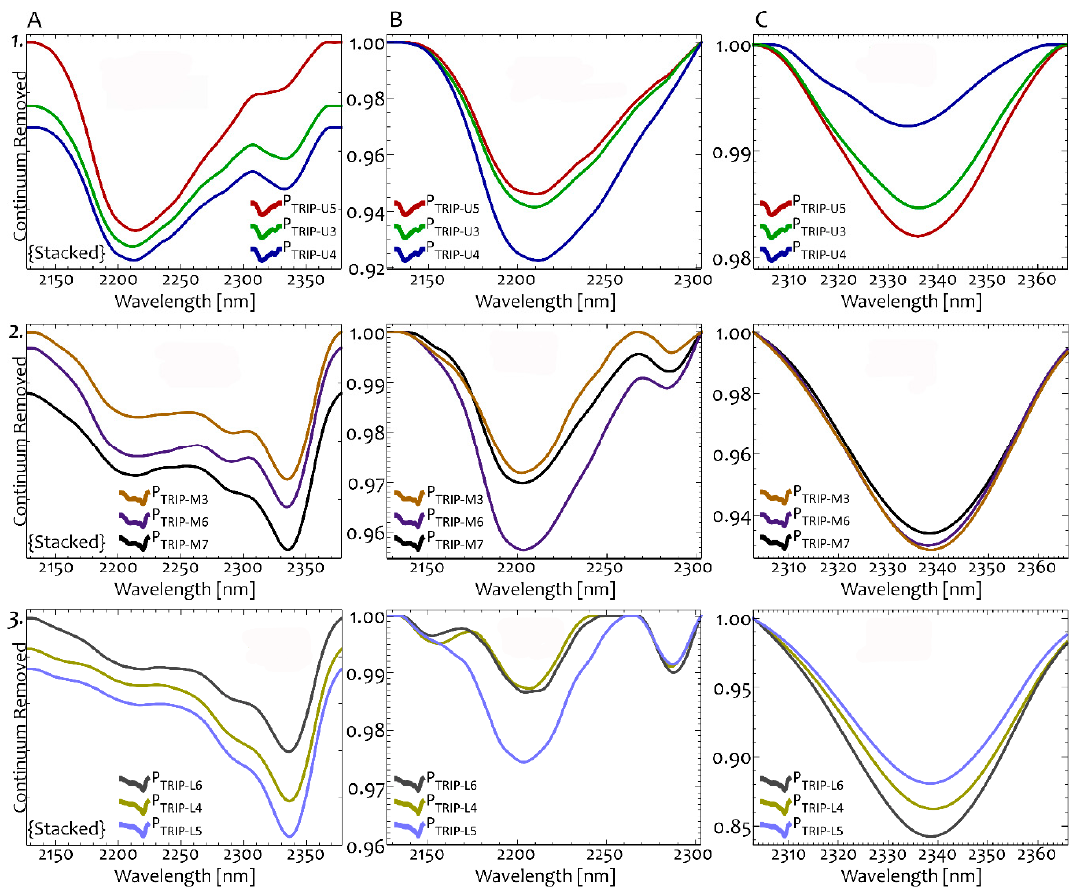
Figure 9. Continuum removed spectra of selected tripolite samples collected from (1) higher levels, (2) middle levels, and (3) lower levels of the roadcut, where accessible. Continuum removal was applied over the wavelength ranges of ( A ) 2128–2378 nm, ( B ) 2128–2302 nm, and ( C ) 2303–2373 nm.